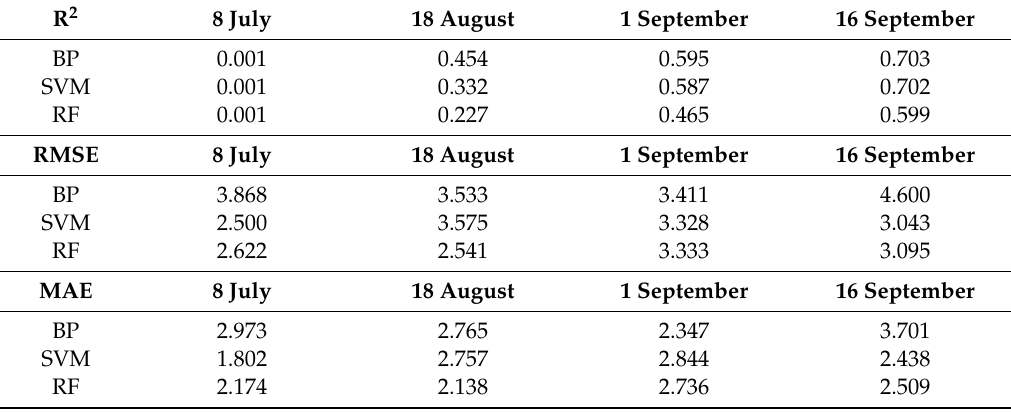
Table 3. The detailed results of R 2 , RMSE, and MAE for di ff erent dates using ML methods. R